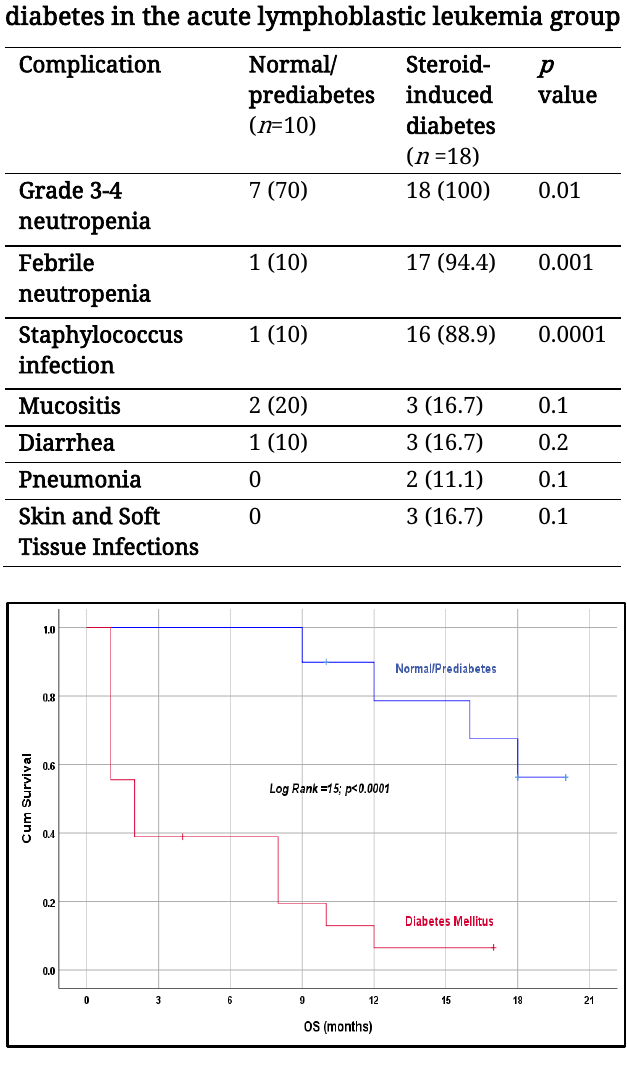
Figure 1: Overall survival curves for normal/ prediabetic patients and those with steroid-induced diabetes in the acute lymphoblastic leukemia group In this group, 15/24 (62.5%) patients developed grade 3-4 neutropenia with febrile